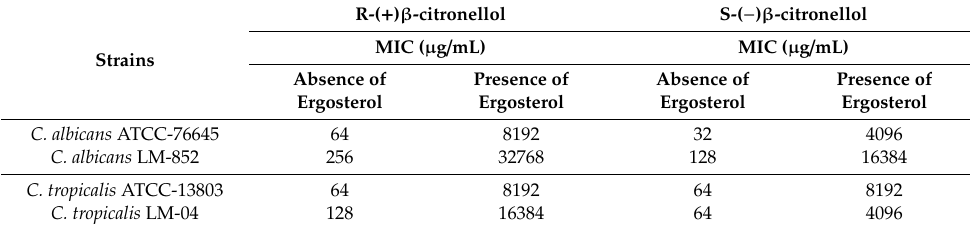
MIC: Minimum inhibitory